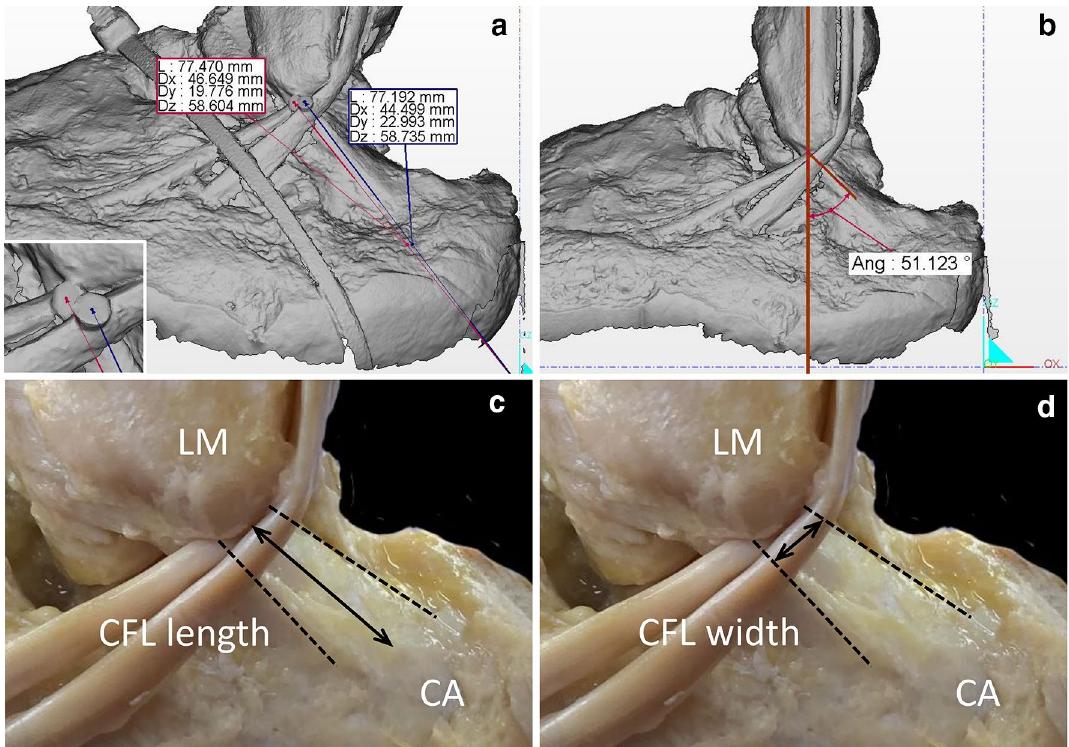
Figure 3. Measurement of the positional coordinate of the peroneal tendons and calcaneofibular ligament (CFL) dimensions. ( a ) The centers of the heads of the pins (inset) are specified as the targets of the positional coordinate. The distances on the x–y–z axis from the origin coordinate to the pins are automatically measured. ( b ) The evaluation of the running angle created by the CFL and fibular long axis. ( c ) The dashed line shows the margin of the CFL. The distance from the fibular origin to the most proximal insertion on the calcaneus is the CFL length. ( d ) The CFL width is measured as the portion where it intersects with the peroneus longus tendon (PLT) and peroneus brevis tendon (PBT). LM lateral malleolus, CA